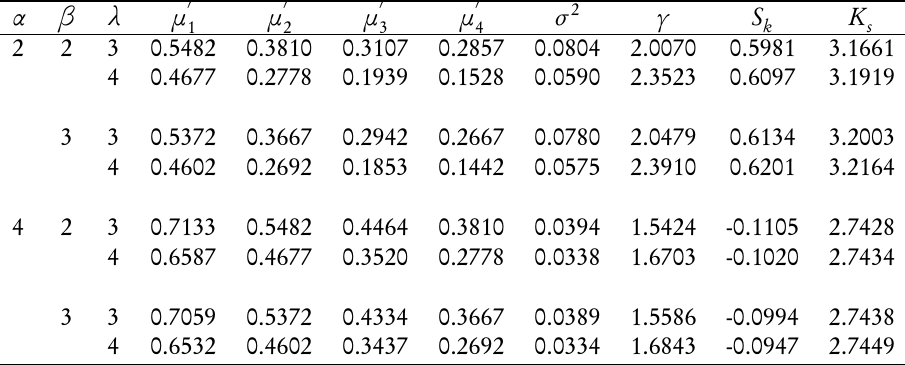
Theoretical moments of TPGLD for selected values of the